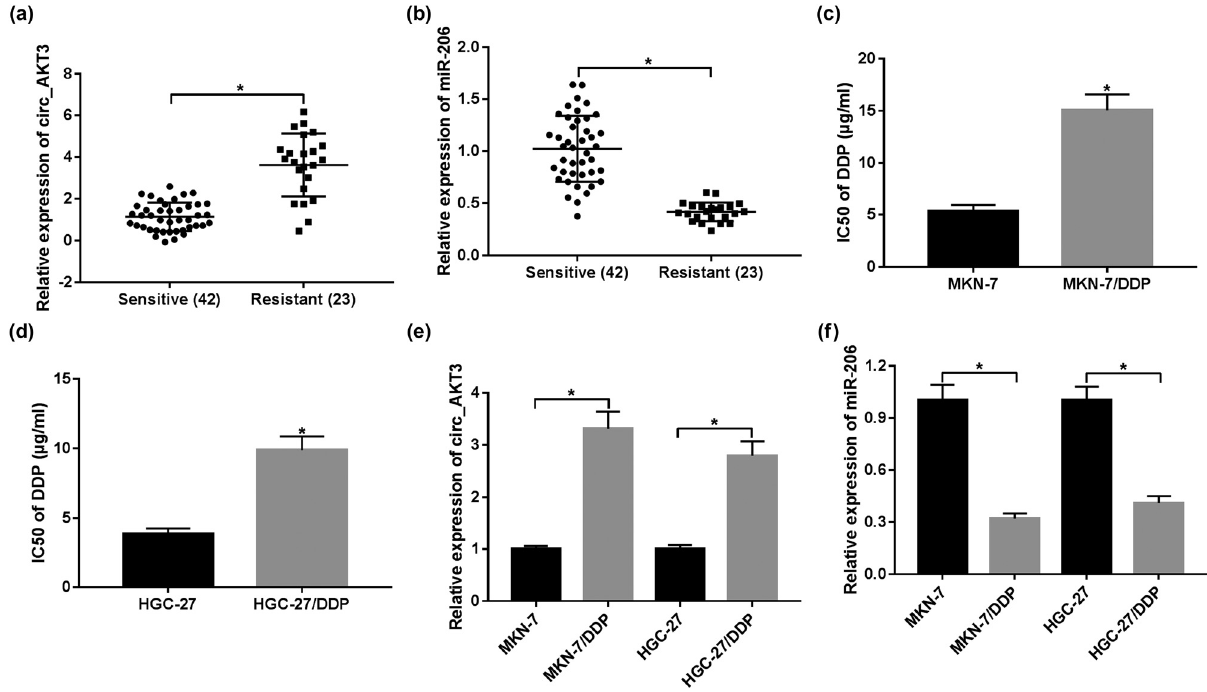
Figure 1: circ_AKT3 expression is elevated and miR - 206 level is decreased in resistant GC. ( a and b ) The levels of circ_AKT3 and miR - 206 were measured in sensitive ( n = 42 ) and resistant ( n = 23 ) GC tissues via RT - qPCR. ( c and d ) The IC 50 of cisplatin was analyzed in MKN - 7, MKN - 7/DDP, HGC - 27 and HGC - 27/DDP cells by MTT assay. ( e and f ) The levels of circ_AKT3 and miR - 206 were detected in DDP - sensitive and DDP - resistant GC cells via RT - qPCR. * P < 0.05.